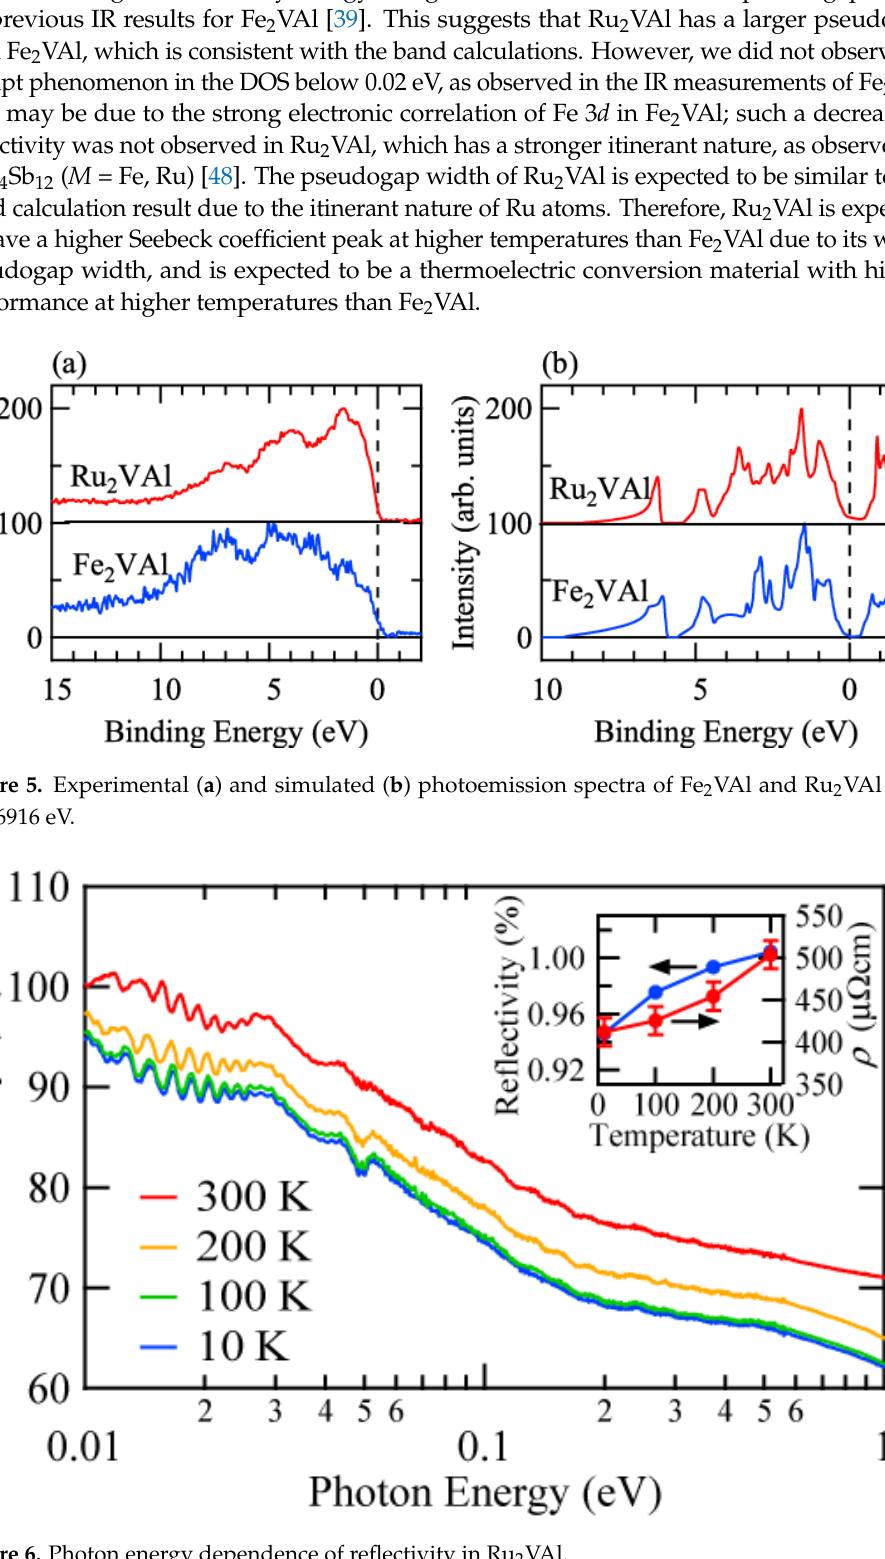
Figure 6. Photon energy dependence of reflectivity in Ru 2 VAl.